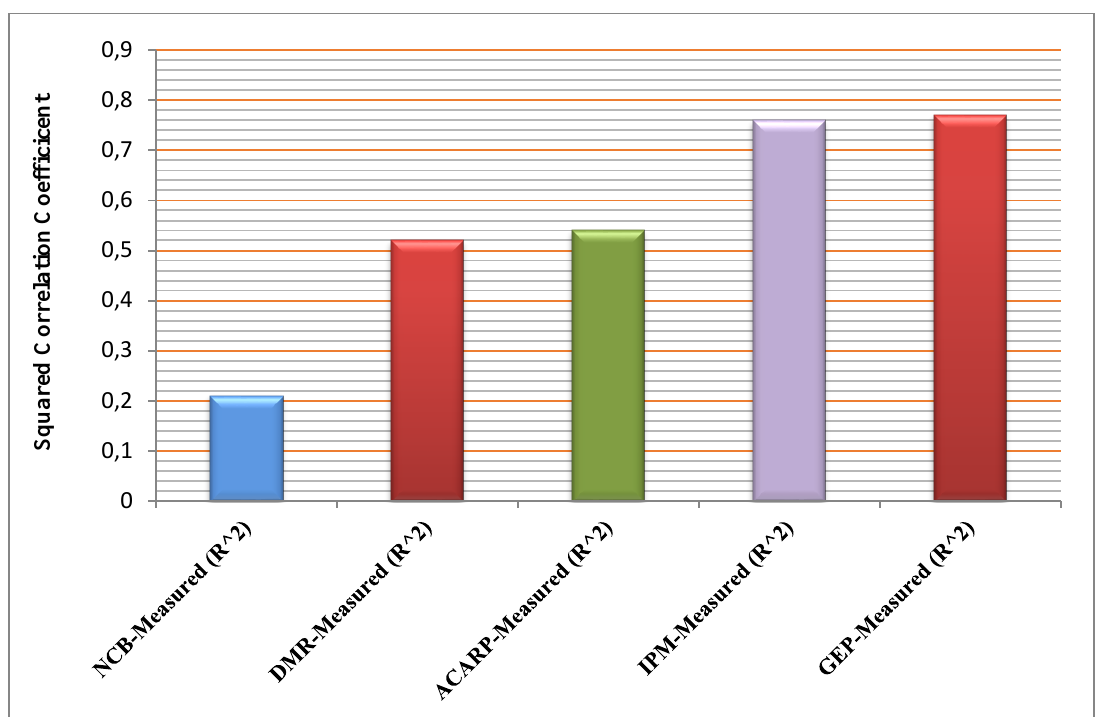
Figure 12: Squared correlation coefficients of measured subsidence and other prediction methods. Source: Authors,